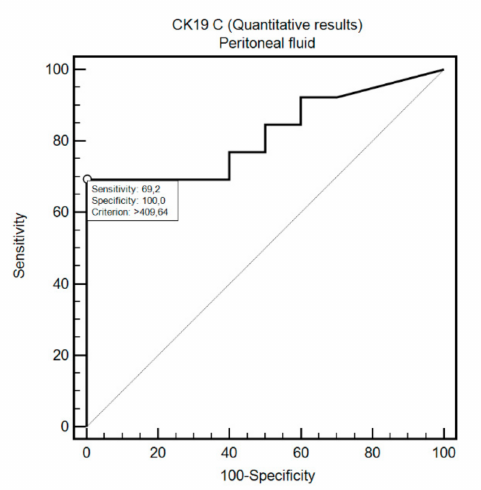
Figure 2. Diagnostic usefulness of CK19 concentration in di ff erentiating positive and negative cytology in the peritoneal fluid samples.